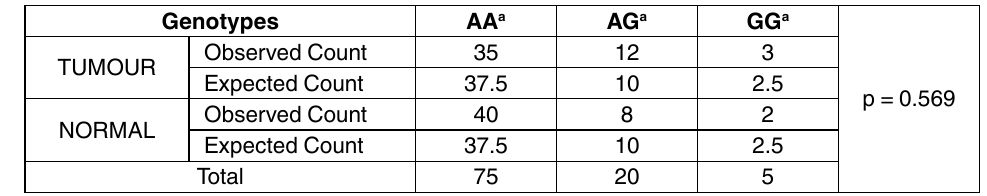
table 2. Association analysis of SNP within BRCA2 with